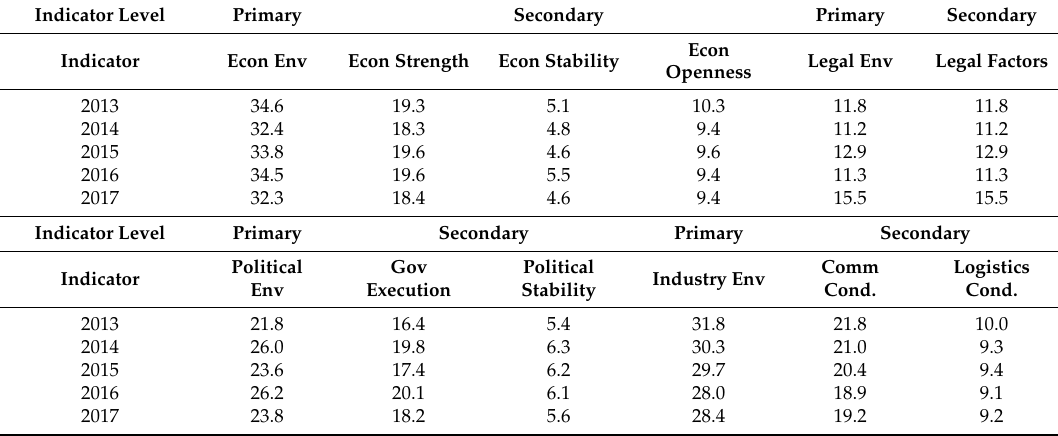
Table 5. Weights of indicators of the first-category